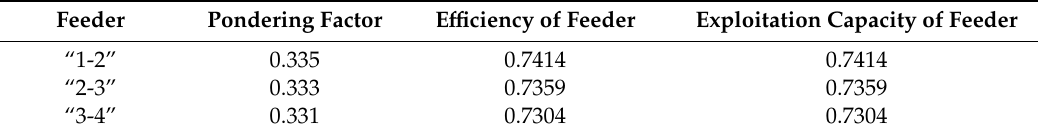
Table 1. Indices calculated for the validation test in the case 1.